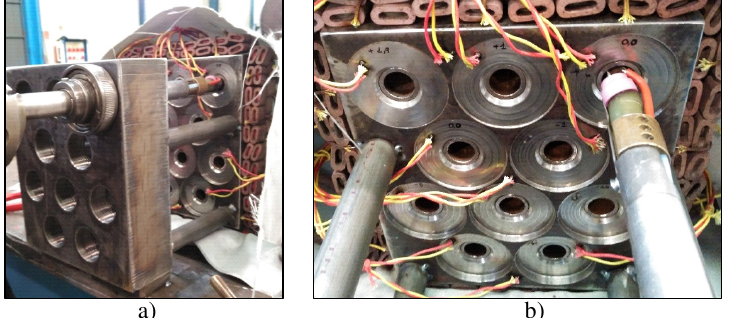
Figure 8. Mounting and welding of mockup 1 during the test: ( a ) General view; ( b ) closer view of tube-to-tubesheet joint with machined holes (parallelism